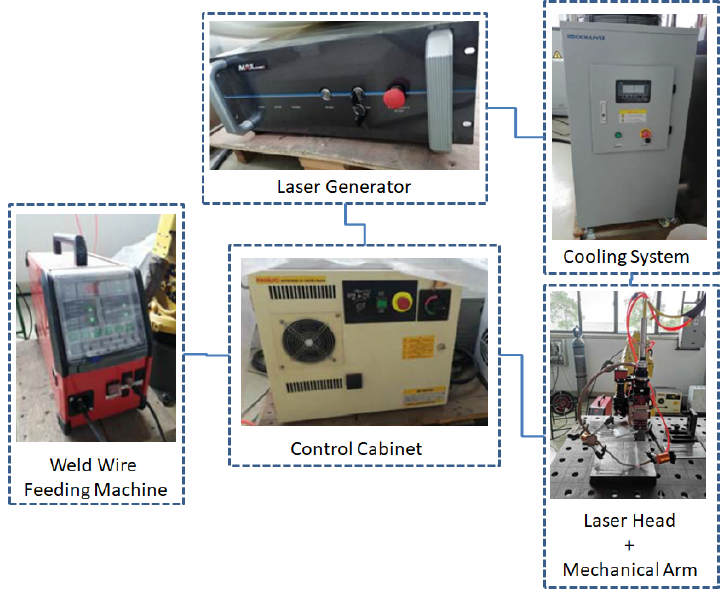
Figure 1. The layout of the laser welding station.